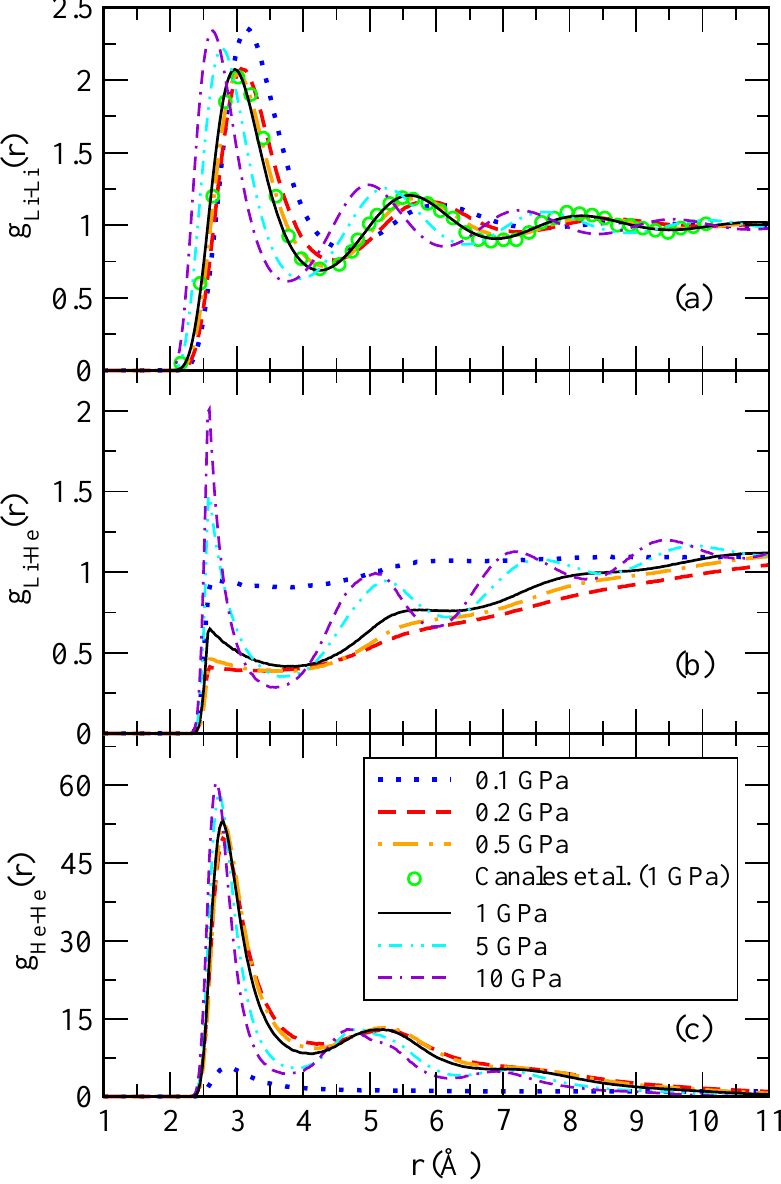
Figure 5. Pair distribution functions in a wide range of pressures (0.1–10 GPa) quantifying ( a ) He-He; ( b ) He-Li; and ( c ) Li-Li correlations. Green circles, single-species Li-Li data from Ref. [30]. Lines: 0.1 GPa (dotted blue); 0.2 GPa (dashed red); 0.5 GPa (dot-dashed orange); 5 GPa (dot-dot-dashed cyan); 10 GPa (dash-dash-dotted